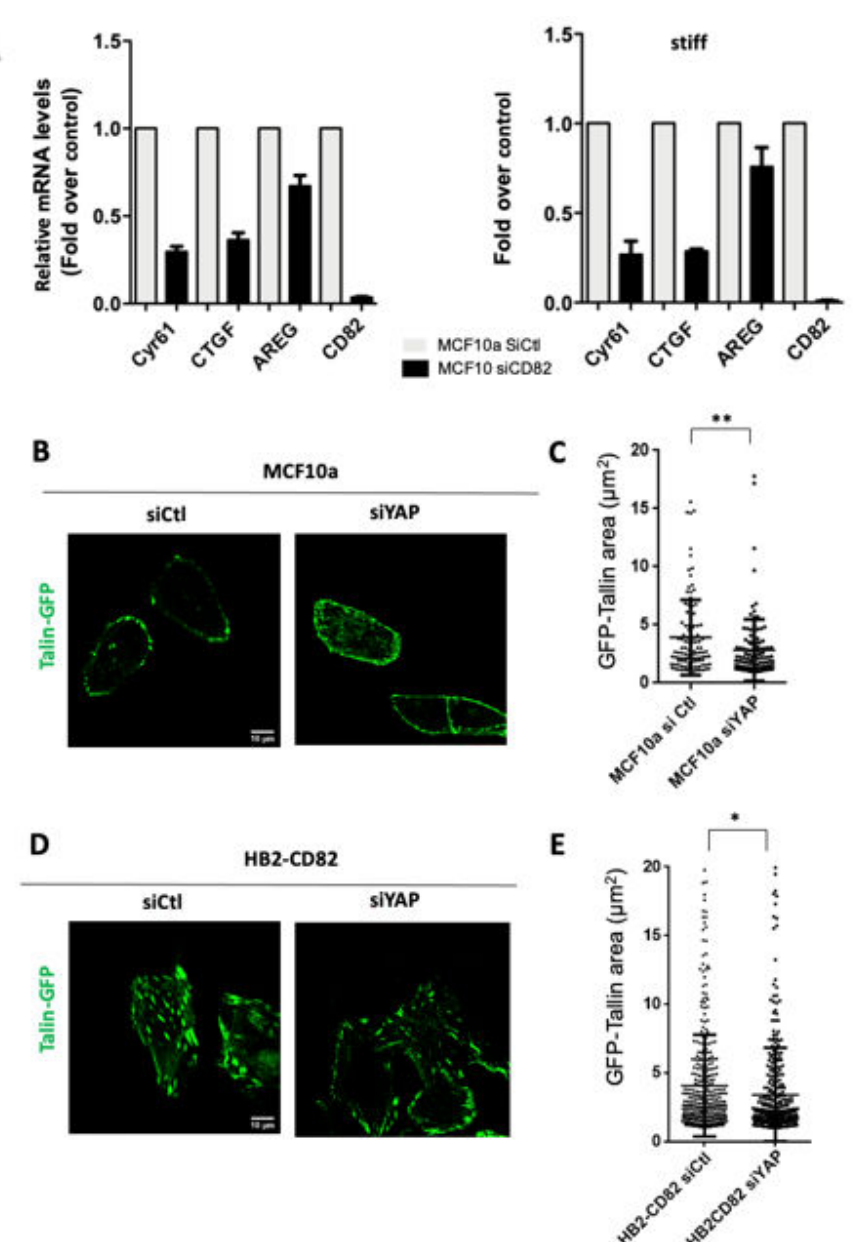
Figure 5. CD82 regulates and depends on YAP. ( A ) Representative RT QPCR analysis of YAP target genes in MCF10a transfected with Si Ctl or Si CD82 cultured on soft (left) and stiff (right) substrates (one experiment is shown here out of 3, done in triplicate). ( B ) Talin-GFP labelling in MCF10a cells transfected with Si Ctl or Si YAP C ) Quantification of the size of the peripheral adhesion areas of 11 cells from 2 independent experiments; ** p < 0.01. ( D ) Talin-GFP labelling in HB2-CD82 cells transfected with Si Ctl or Si YAP ( E ) Quantification of the size of the peripheral adhesion areas of 13 and 14 cells, respectively; * p <